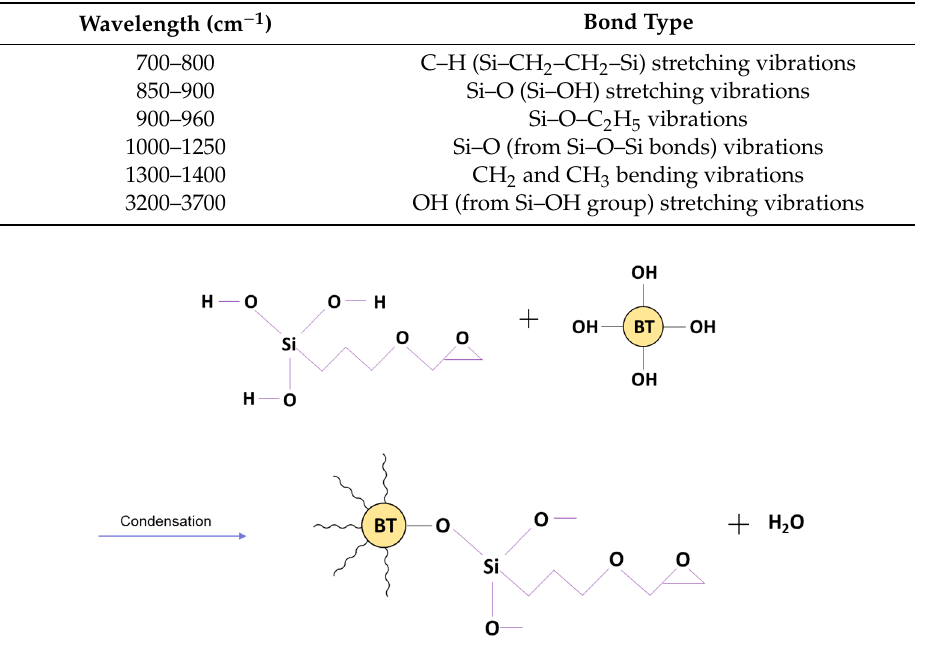
Table 5. Wavelength (cm − 1 ) and bond type found in silane films.